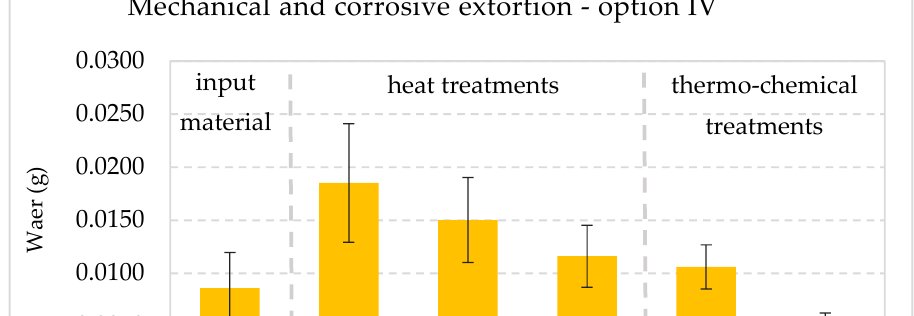
Figure 16. Wear I M + I C in the conditions in mechanical and corrosive conditions (no action from abrasive agents) with 90% confidence semi-intervals [40].